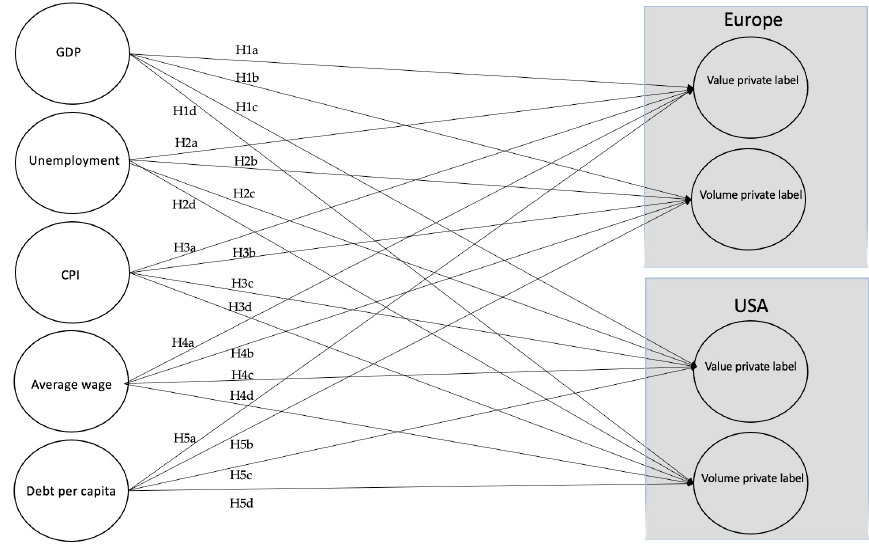
Figure 1. Proposed model .